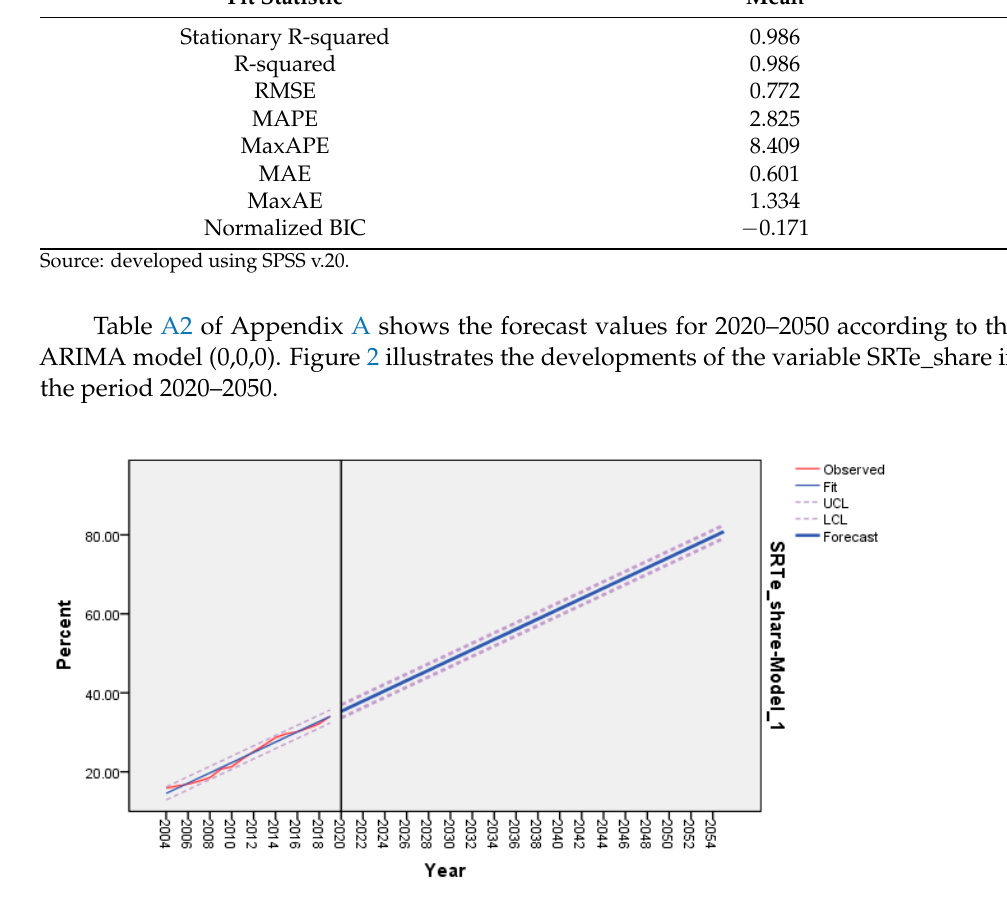
Figure 2. Forecast of developments in the share of the total electricity consumed from renewable sources. Notes: UCL—upper-case limits; LCL—lower confidence limits. Source: developed using SPSS